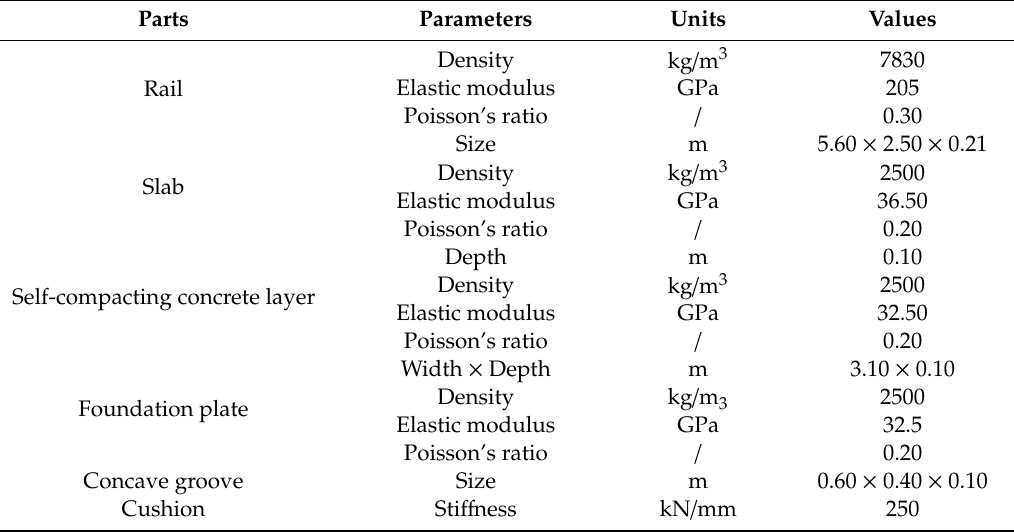
Figure 3. Structural components of CRTS Ⅲ slab track. Table 2. Structure parameters of CRTS Ⅲ slab track.